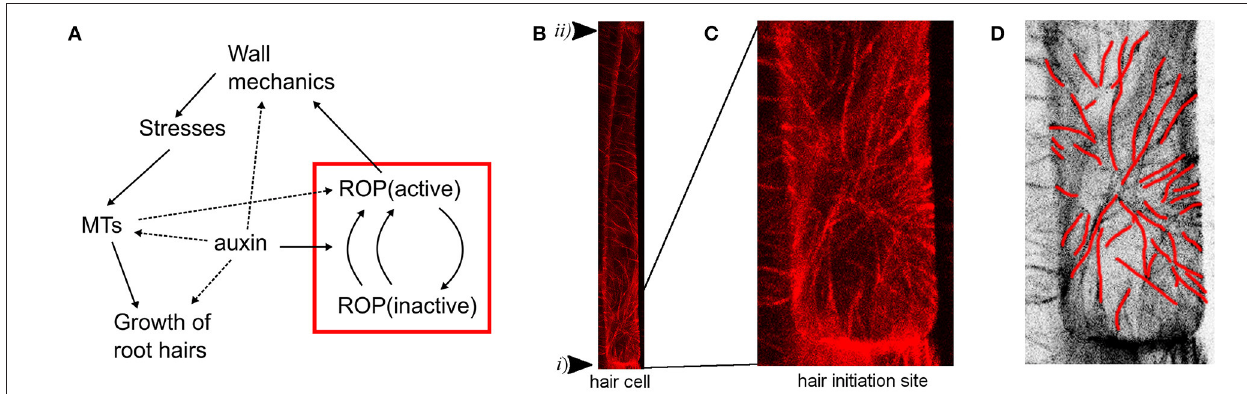
FIGURE 1 | Root hair initiation is dependent on ROP activation and microtubular dynamics. (A) Model diagram of the root hair initiation process including feedback between cycling of ROPs and mechanical properties via microtubular dynamics. Solid lines represent mechanisms explicitly modeled, dashed lines are implicitly in the models or suggested in the literature. The red box represents the ROP model tested in 2D simulations and the arrow from the ROP to mechanics is evaluated by testing different hypotheses. (B) Pattern of cortical microtubules in a root epidermal cell visualized by RFP-TUB6, underlying the root epidermal cell membrane of a 5-day-old Arabidopsis thaliana seedling. The arrowheads mark basal (i) and apical (ii) ends of the cell. In the top part a mainly transverse pattern of microtubules can be seen, while a star-like radial pattern around the root hair initiation site can be seen at the lower end. (C) Magnification of the radial pattern in the lower part of the cell from (B) showing root hair outgrowth site. (D) Microtubules directions marked with red lines in inverted image of C .